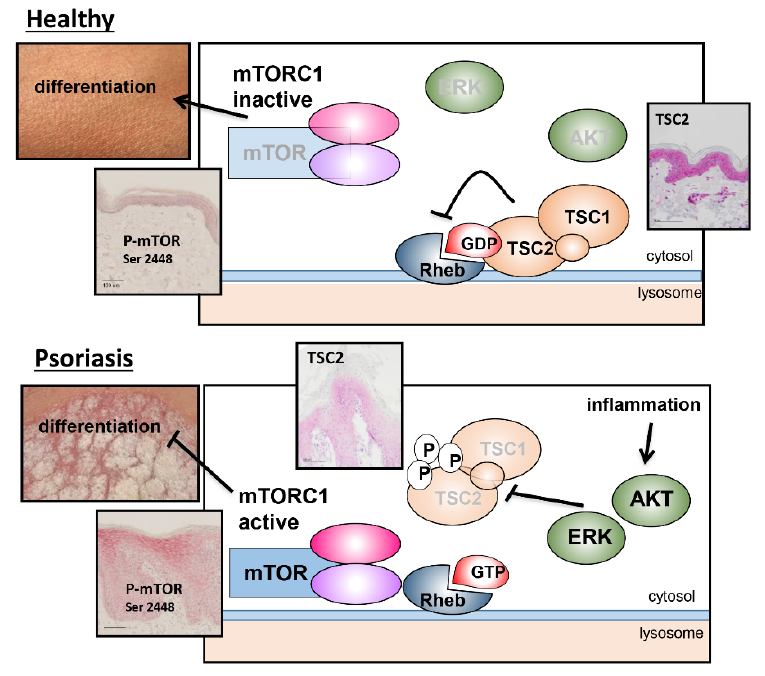
Figure 6. Mechanistic scheme on the regulation of the TS complex in healthy and psoriatic skin.